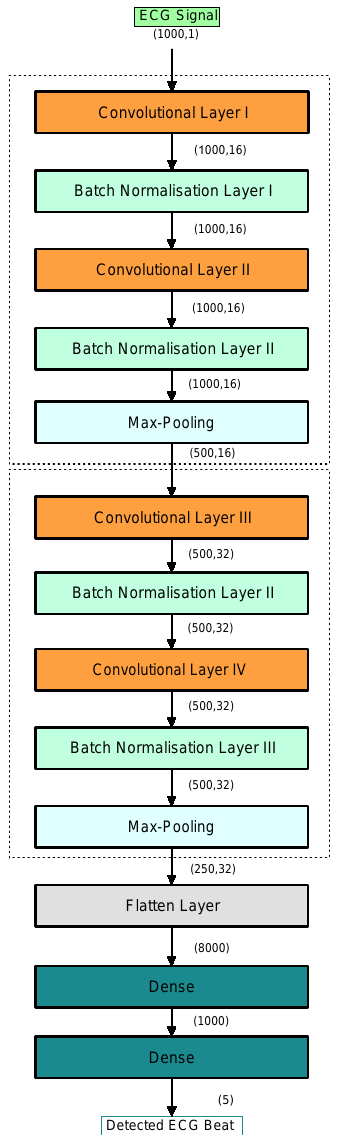
Figure 2. The architecture of the deep learning